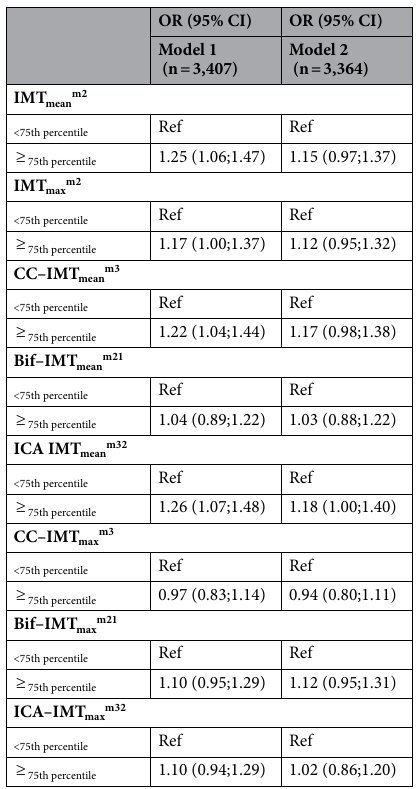
Table 2. Odd Ratios (OR) and 95% confidence interval (CI) of abnormal C-IMT for high consumption of food rich in saturated fat (vs. low) in the participants of the IMPROVE study. m: missing. Model 1: Sex- and age-adjusted. Model 2: Model 1 plus level of education (categorical), physical activity (categorical), smoking, alcohol consumption (categorical) and population structure (MDS1-3,